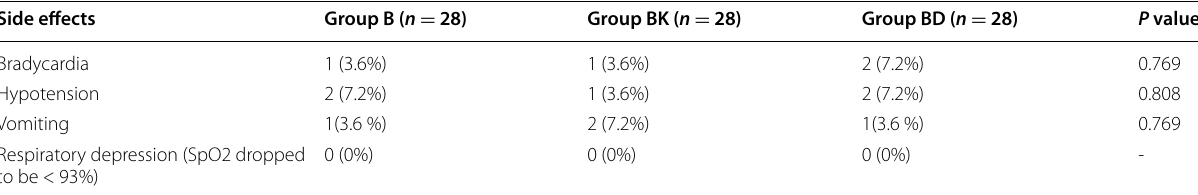
Table 9 Perioperative complications. Data is expressed as number (%) Side